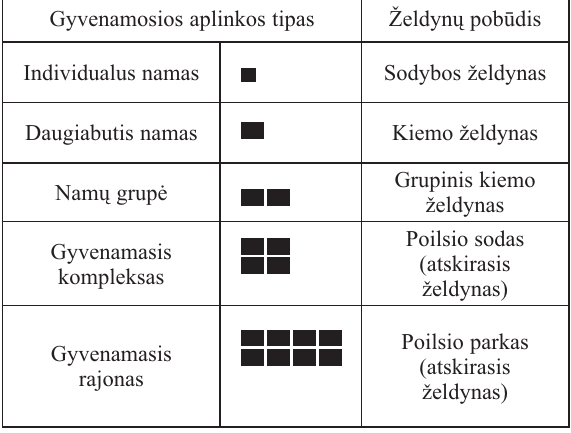
Fig 8. Dependence of green area character upon the type of living